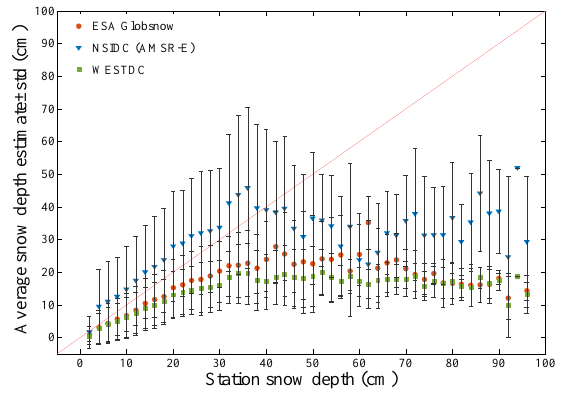
Table 4. Root mean square error (RMSE) and bias for